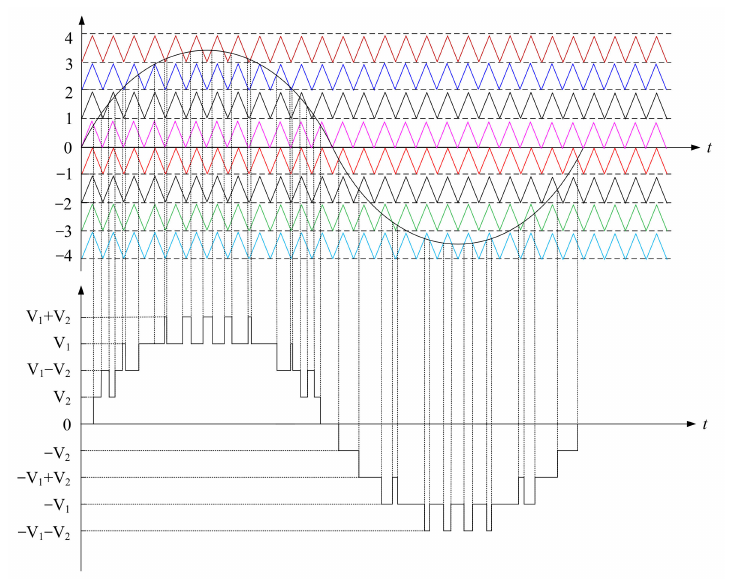
Figure 7. The carrier disposition